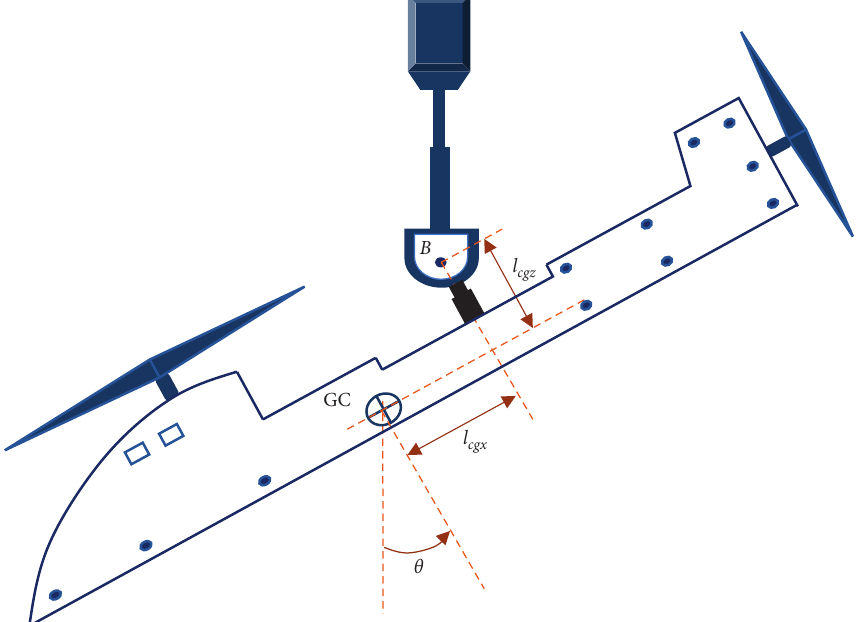
Figure 1: Simplified pitch model of the helicopter, from